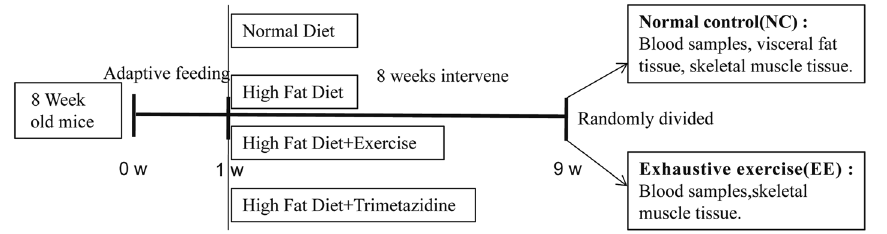
Figure 7. Diagram of animal experiments. After a 1-week adaptive feeding, mice were randomly divided into four groups: normal diet (ND), high-fat diet (HFD), HFD + Trimetazidine (HFD + TMZ), and HFD + exercise (HFD + EX). 8 weeks later, mice in each group were randomly divided into two subgroups: normal control subgroup and exhaustive exercise (EE) subgroup, the subsequent experiments were performed as the diagram shows.